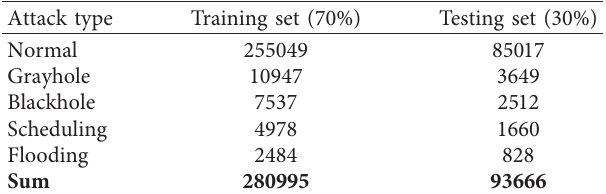
Table 6: The KDD dataset separated 70% training set and 30% testing